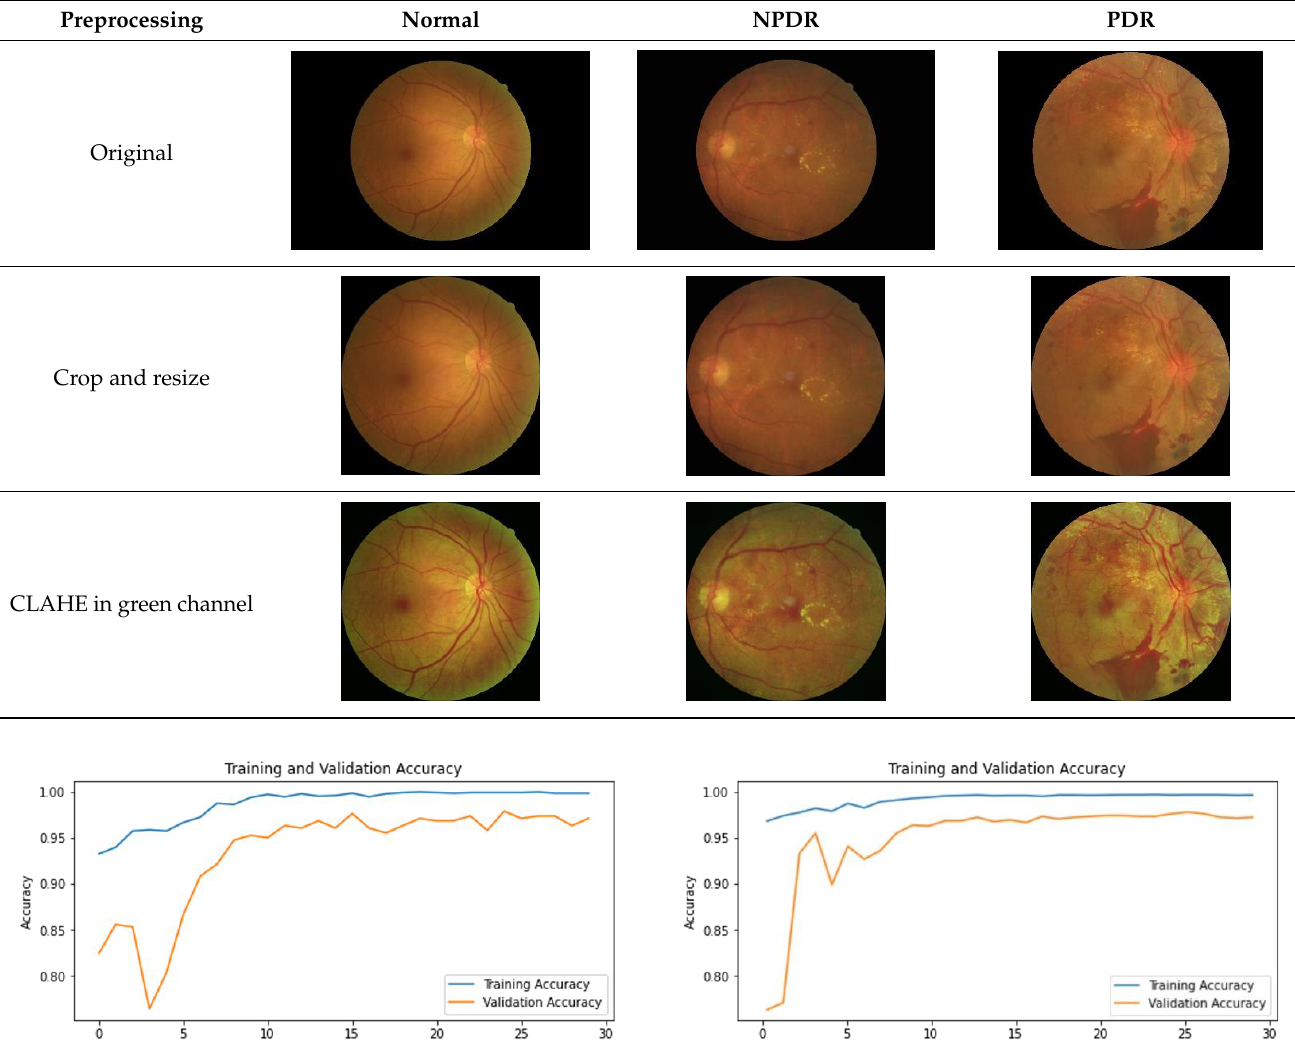
Table 2. Examples of pre-processing implementations.